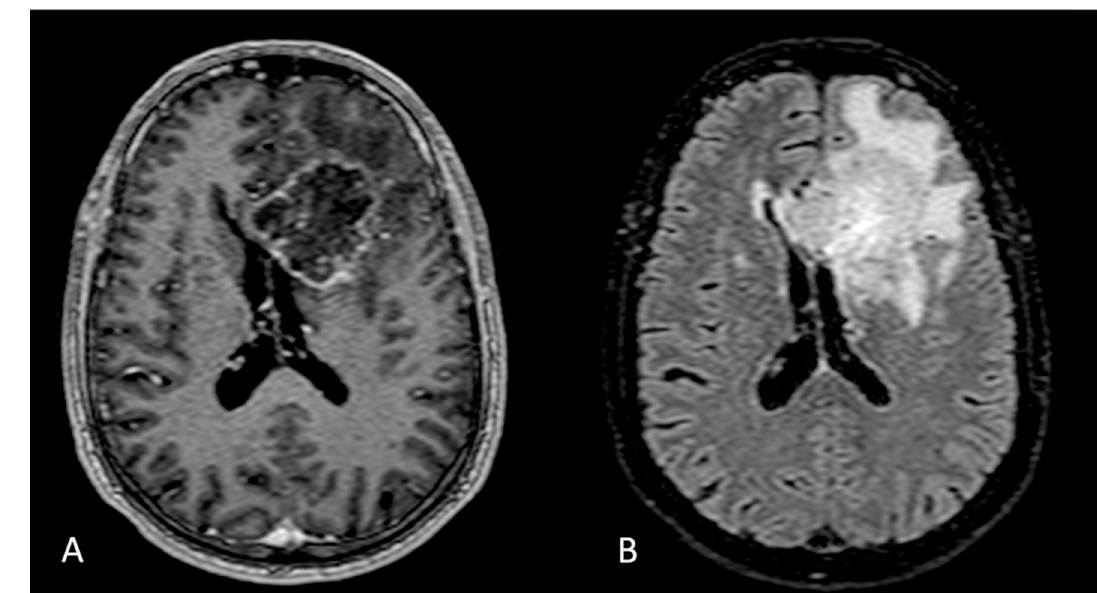
Figure 3. Axial section of MRI T1 with gadolinium ( A ) and FLAIR sequences ( B ). Left frontal lobe GBM with involvement of the corpus callosum.